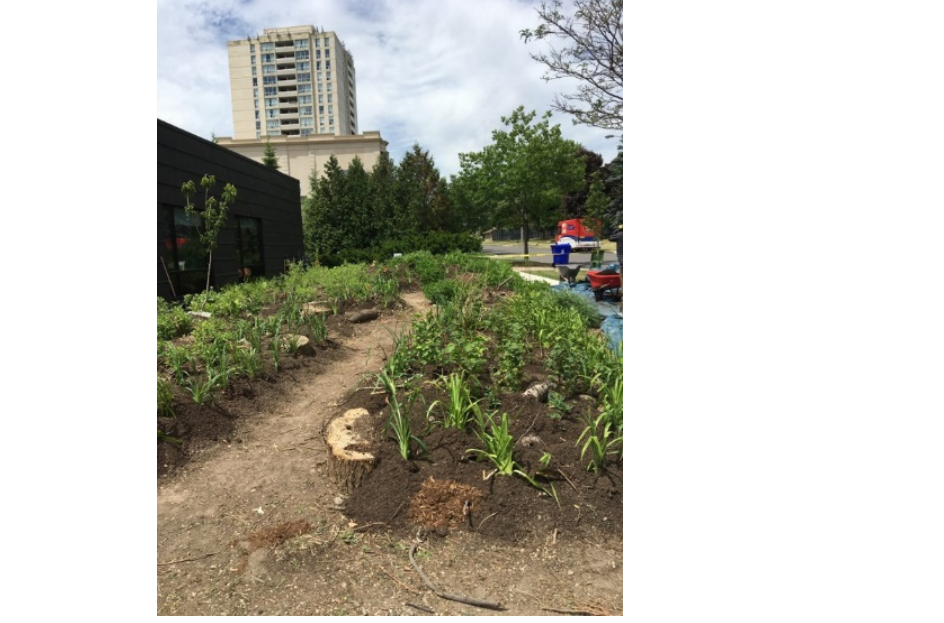
Figure 21. A view of the north garden being re-planted using ‘Hugelkulture’ to grow fruits and vegetables (Credit: St. Gabriel’s parish).